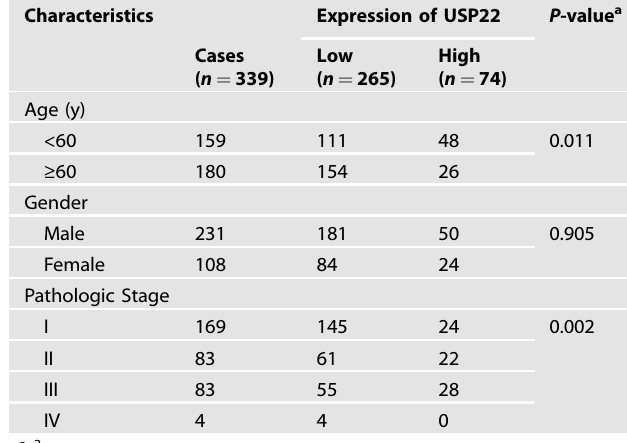
Table 1. Relationship between USP22 expression and Pathologic Stage in